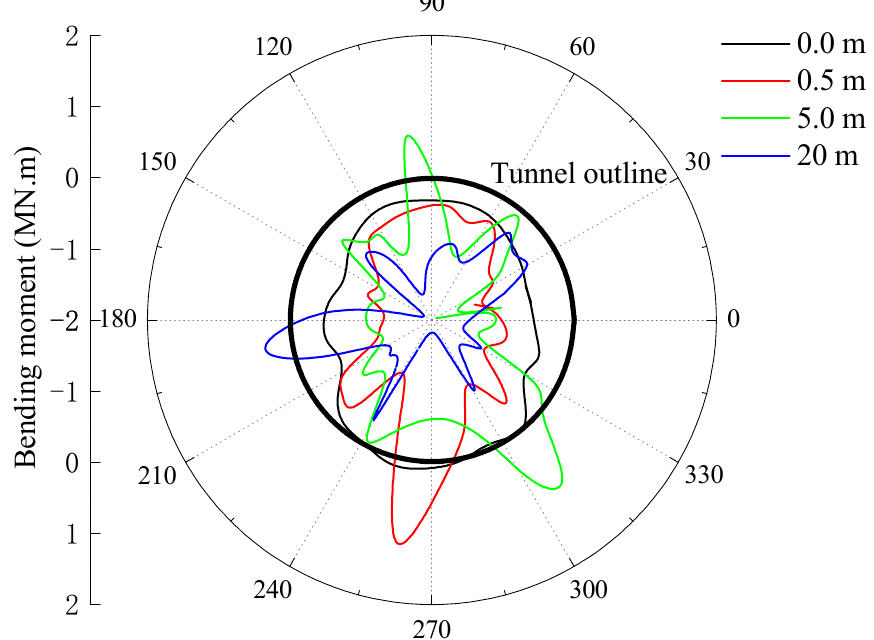
Figure 7. Bending moment of lining of the tunnel passing through adverse geological structure zone with different thicknesses for cross section at y = 500 m.